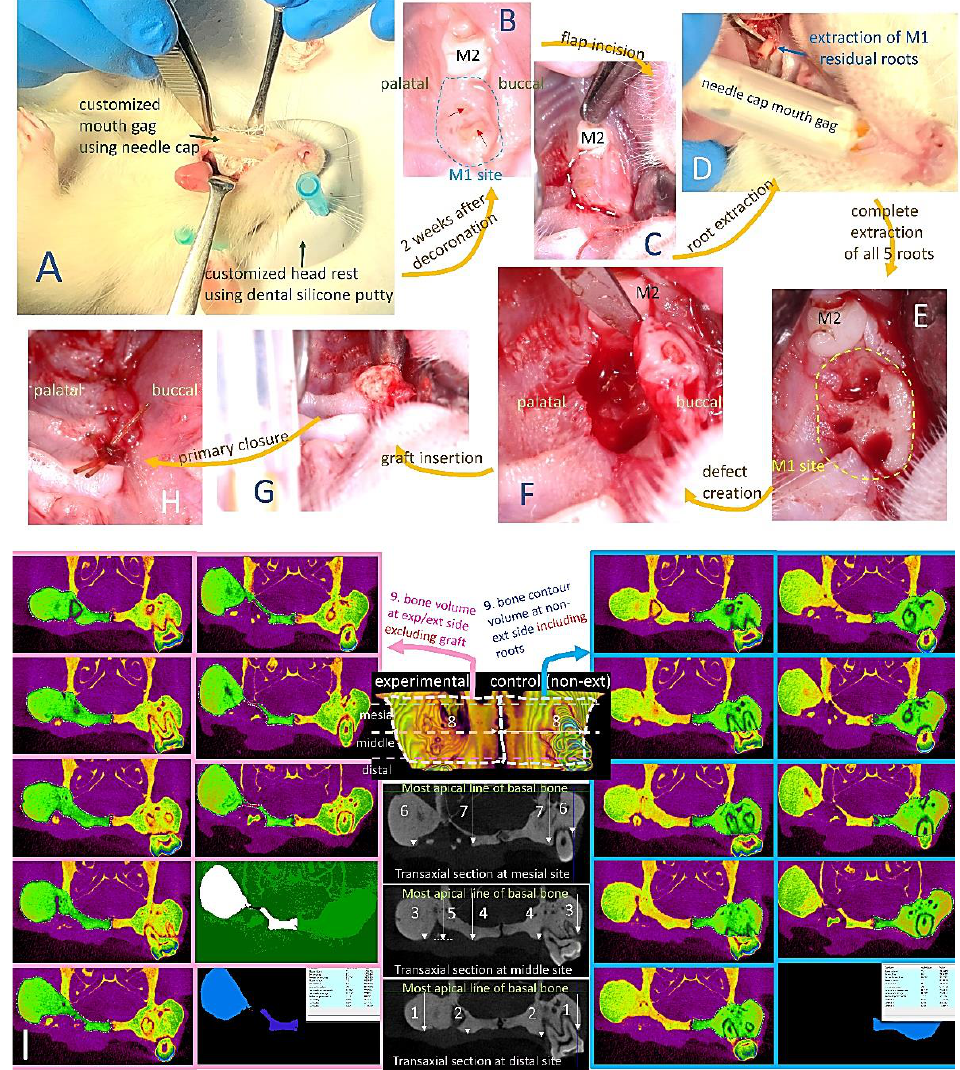
Figure 6. The experimental procedures of the critical size rat alveolar bone defect model and mea- surements of parameters. ( A ) Rat was positioned in dorsal recumbency with customized mouth gag (using needle cap) and head rest (fabricated with dental silicone putty). On the experimental/grafting side, decoronation of maxillary first molar (M1) was performed. ( B ) Preservation of alveolar ridge and soft tissue at M1 site (circled with blue dashed line) two weeks after decoronation. Red arrows indicate some roots are exposed through the soft tissue. ( C ) Semilunar flap incision at M1 site. ( D ) Extraction of M1 roots. ( E ) M1 socket after complete removal of all five roots. ( F ) A standardized alveolar bone defect (bone defect measuring approximately 3 mm in diameter and 2 mm depth) was drilled using low-speed tungsten carbide round bur (diameter 2.7 mm) by aiming the center of inter-radicular septa till the depth that the bur head just submerged into the level of soft tissue surface. ( G ) The bone defects were randomly assigned to be filled with metformin-incorporated gelatin/nano-hydroxyapatite sponge (GHMS), Sinbone granules (60%HA + 40% β -TCP), or Bio-Oss Collagen ® ( H ). Primary closure was achieved using resorbable vicryl 6-0 sutures. ( I ) Micro-computed tomography assessments of alveolar bone dimension at maxillary first molar (M1) sites, namely (1) distal buccal bone height, (2) distal palatal bone height, (3) distal middle buccal bone height, (4) middle palatal bone height, (5) middle graft height, (6) mesial buccal bone height, (7) mesial palatal bone